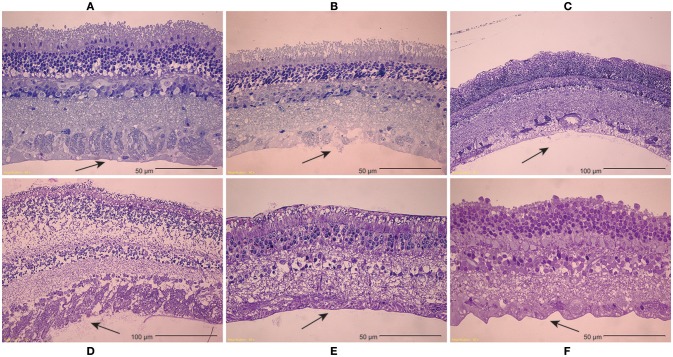
(A–C) Light microscopy images of peeled sheep retinas indicate (A) failure primarily occurred at the ILM. (B) In some images, focal ILM disruption was noted, (C) particularly in the presence of blood vessels. There were no regional differences in failure location, but immature sheep eyes tended to have more ILM disruption than young adult sheep eyes. (D–F) For human eyes, (D) peeling in the posterior pole typically disrupted the ILM, (E) while peeling in the equator had a clean separation between the vitreous and retina. (F) This clean separation was sometimes accompanied by traction-like undulations on the retinal surface.